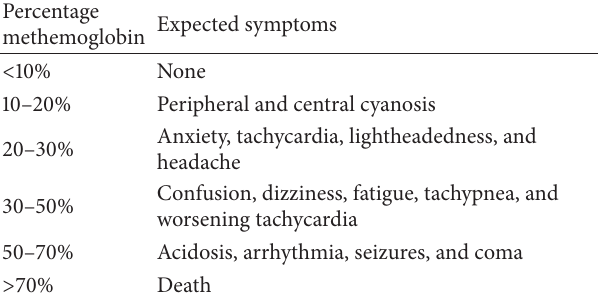
Table 1: Expected signs and symptoms for a given percentage methemoglobin level assuming normal starting hemoglobin [6,